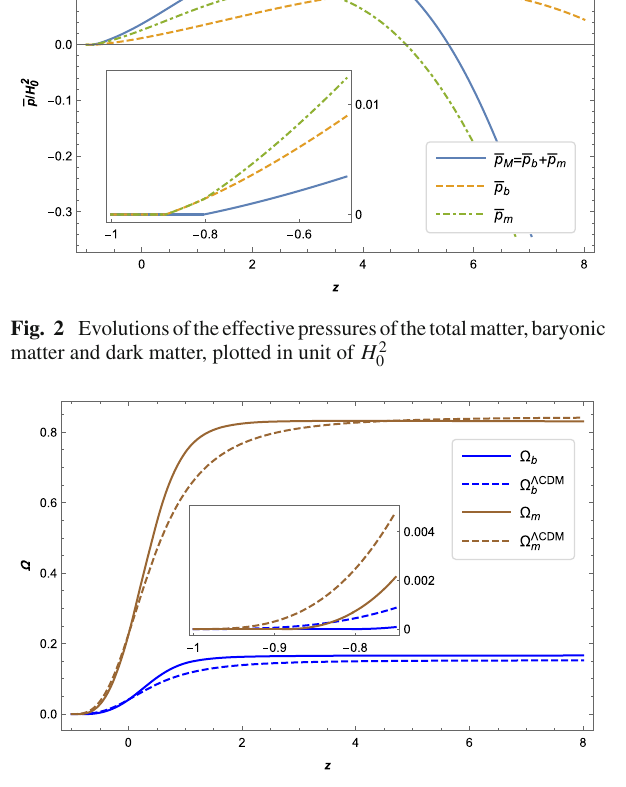
Fig. 5 The evolutions of the density parameters. (cid:9) f ( T ) denotes the effective density parameter of the f ( T )